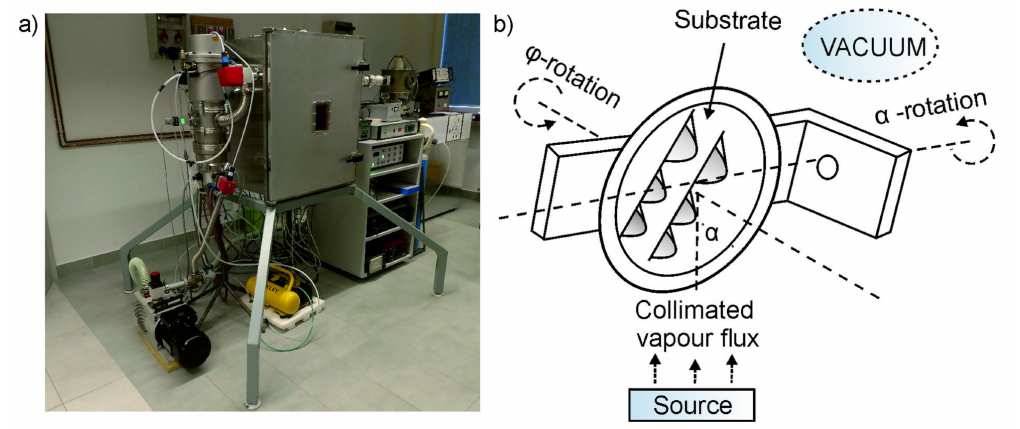
Figure 1. Photo of the magnetron sputtering system with a GLAD manipulator ( a ) and a sketch of the manipulator for GLAD deposition technique ( b ). Reprinted from [48] under CC BY